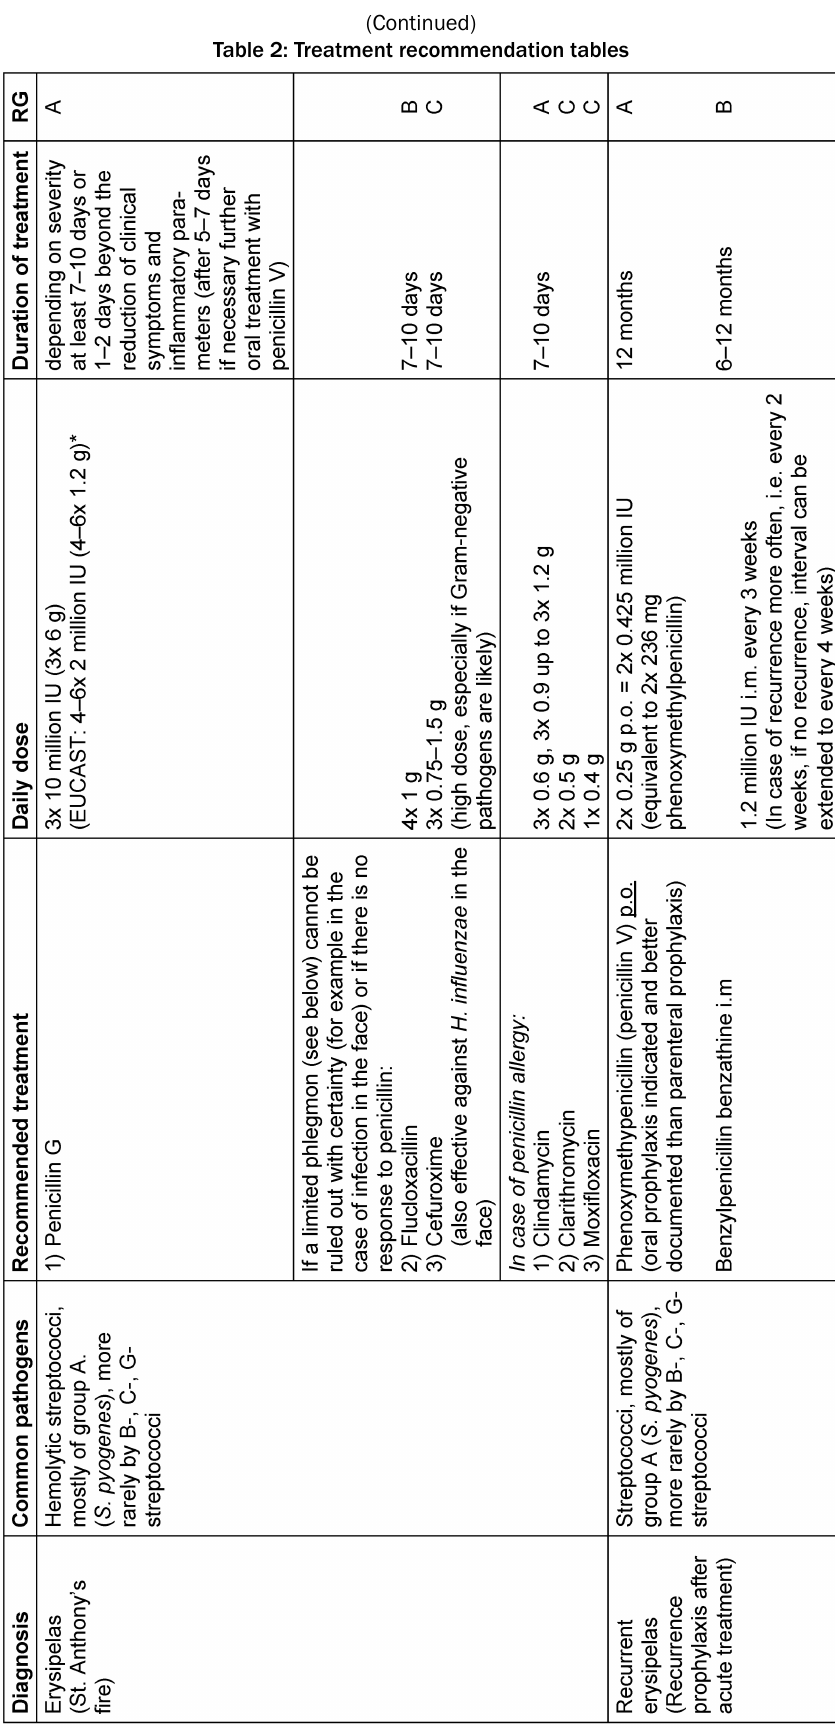
Table 2: Treatment recommendation